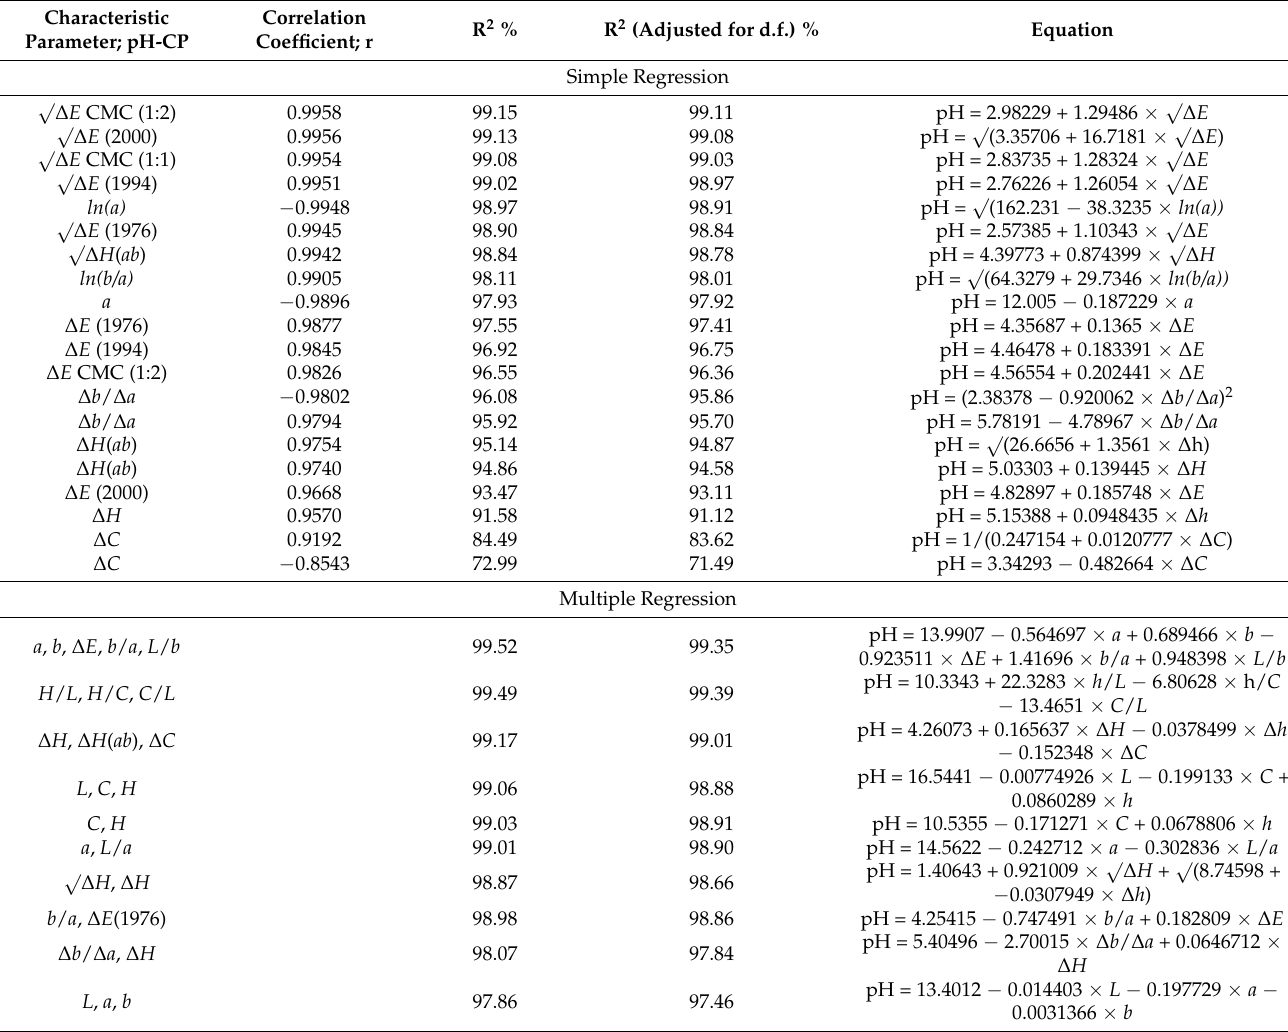
Table 2. Determination of pH materials, statistically significant expressions. The values of adjusted R 2 for relationships between candidate surface pH characteristic CIE color parameters (the tested orthogonal and cylindrical parameters, derived ratios, and total and partial color differences including both differences of hue ∆ h ab and ∆ H ab ) and the surface pH of material (model paper samples—methyl red indicator containing acid paper with pH 0 = 4.2); modified using Mg(HCO 3 ) 2 solution gradually diluted c mol/L <0.0002, 0.2>; surface pH values of samples <4.3,